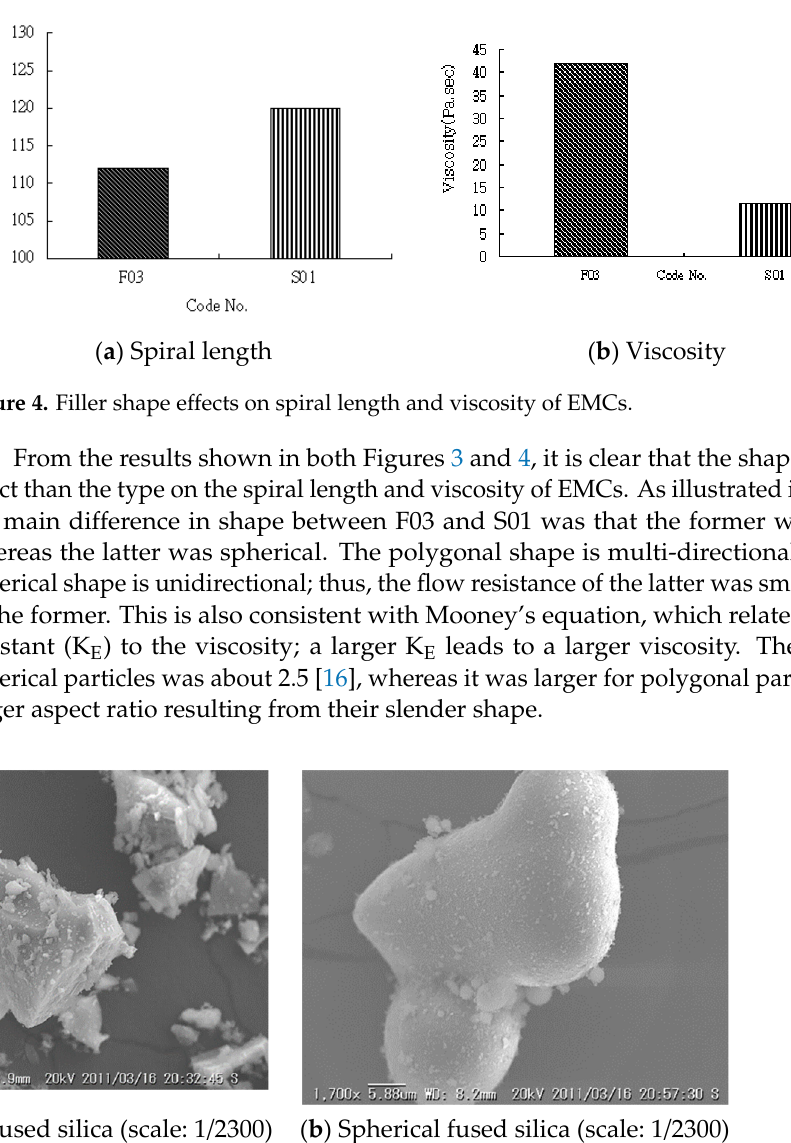
Figure 5. Shape feature of polygonal and spherical silica (scale bars are 4.34 and 5.88 µm for ( a ) and ( b ), respectively).